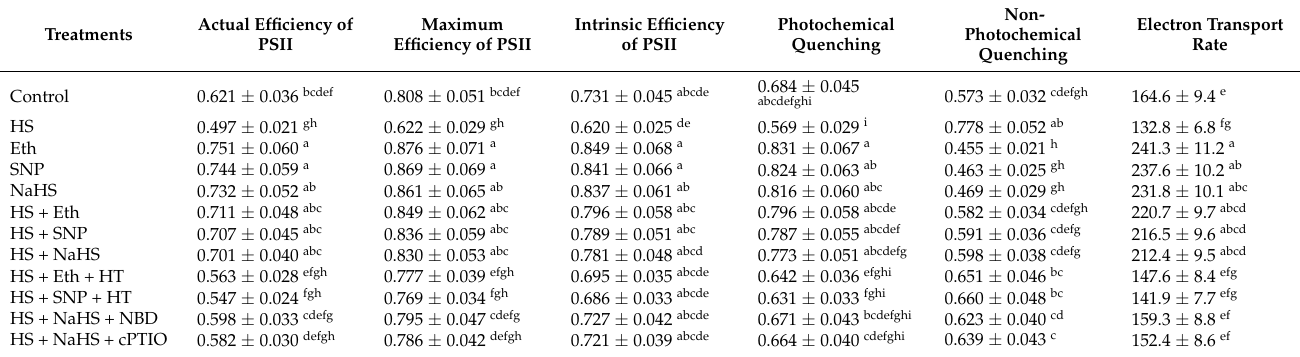
Table 2. Actual efficiency of PSII, maximal efficiency of PSII, intrinsic efficiency of PSII, photochemical quenching, non-photochemical quenching, and electron transport rate of rice ( Oryza sativa L.) cultivar Taipei-309 after foliar treatment of plants with 200 µ L L − 1 ethephon (Eth), 100 µ M sodium nitroprus- side (SNP), or 200 µ M sodium hydrosulfide (NaHS) grown with or without high temperature stress (HS; 40 ◦ C) or 100 µ M hypotaurine (HT), 100 µ M 2-4-carboxyphenyl-4,4,5,5-tetramethylimidazoline- 1-oxyl-3-oxide (cPTIO) or 100 µ M norbornadiene (NBD) scavengers of hydrogen sulfide (H 2 S), nitric oxide (NO), and ethylene action inhibitors, respectively, with HS at 15 days after sowing. Data are presented as treatments mean ± SE ( n = 4). The values followed by the same letters did not differ significantly by LSD test at p < 0.05.